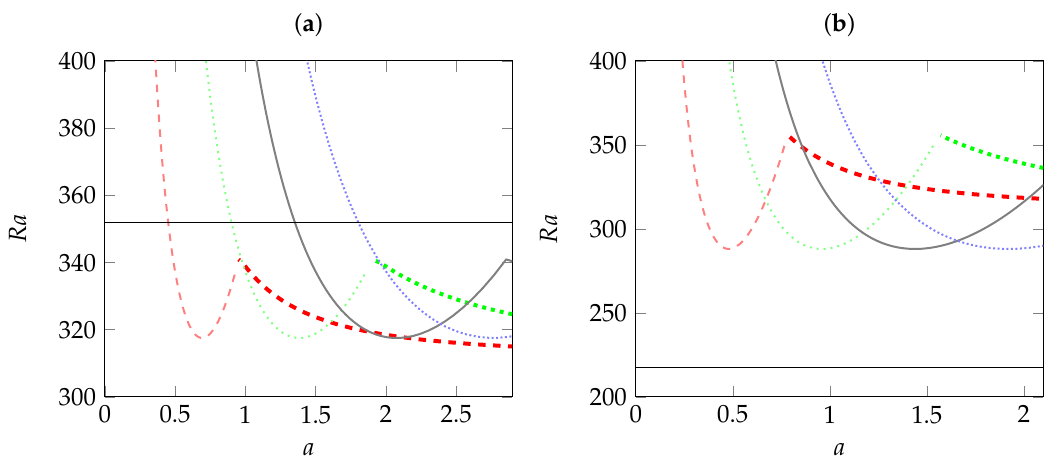
Figure 8. Critical Rayleigh number for the onset of steady (ultra thick curves) and oscillatory (thick curves) longitudinal rolls as a function of aspect ratio a for different numbers L of rolls ( L = 1: red dashed curve; L = 2: green dotted curve; L = 3: black dash-dotted curve; L = 4: blue densely-dotted curve). ( a ) Γ = 0.75 and λ 1 = 0.3; ( b ) Γ = 0.5 and λ 1 = 0.1. The horizontal line corresponds to the threshold of oscillatory transverse rolls.